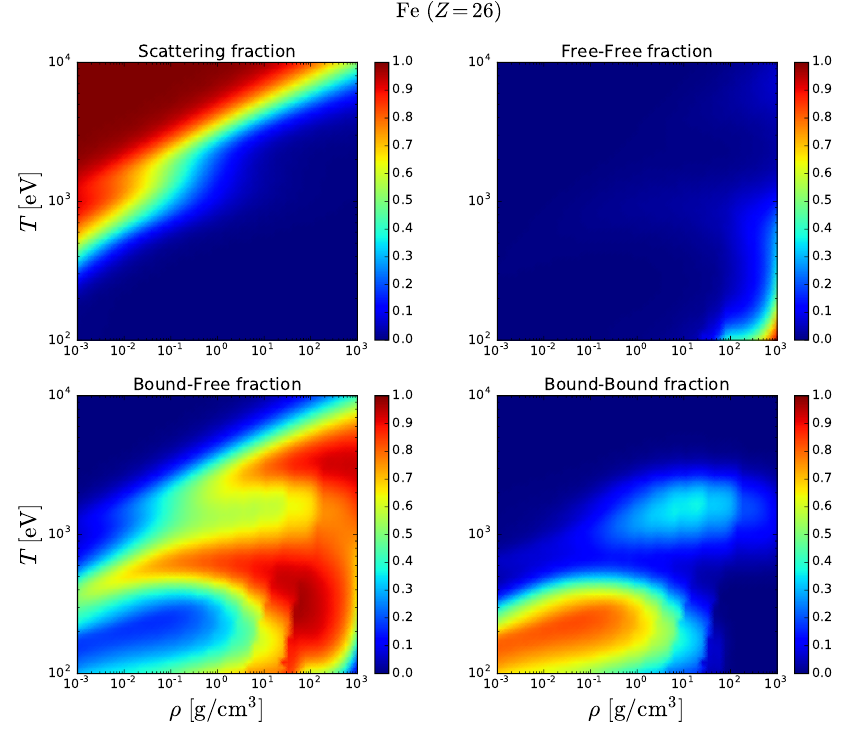
Figure 7. Maps on the temperature-density plane of the scattering (upper left pane), free-free (upper right pane), bound-free (lower left pane) and bound-bound (lower right pane) atomic processes contributions to the Rosseland opacity for